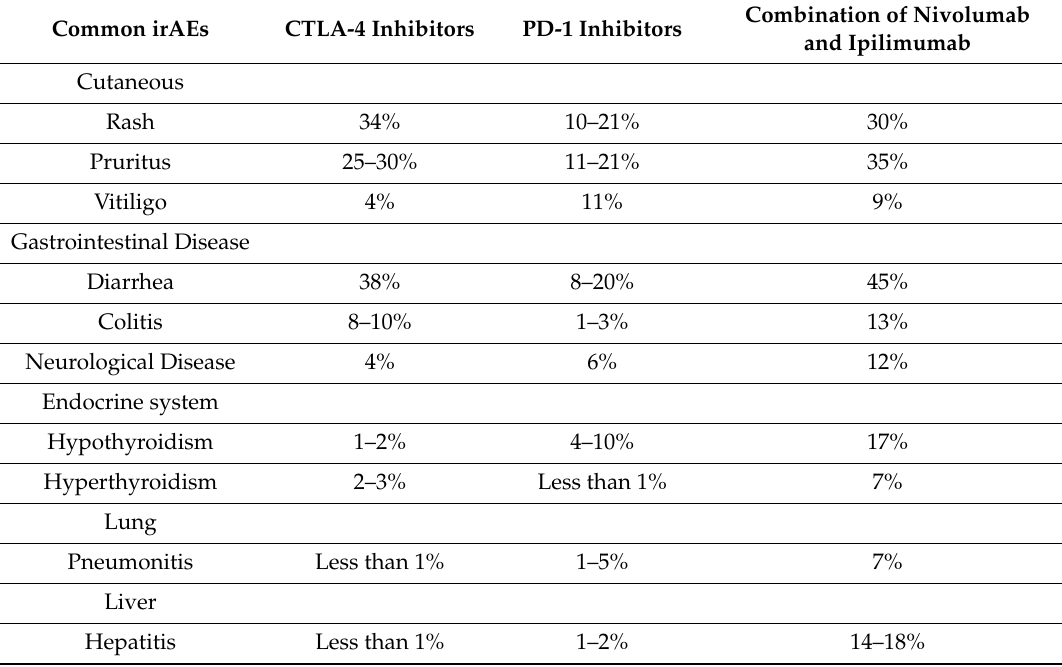
Table 10. The incidence of irAEs induced by immune checkpoint inhibitors